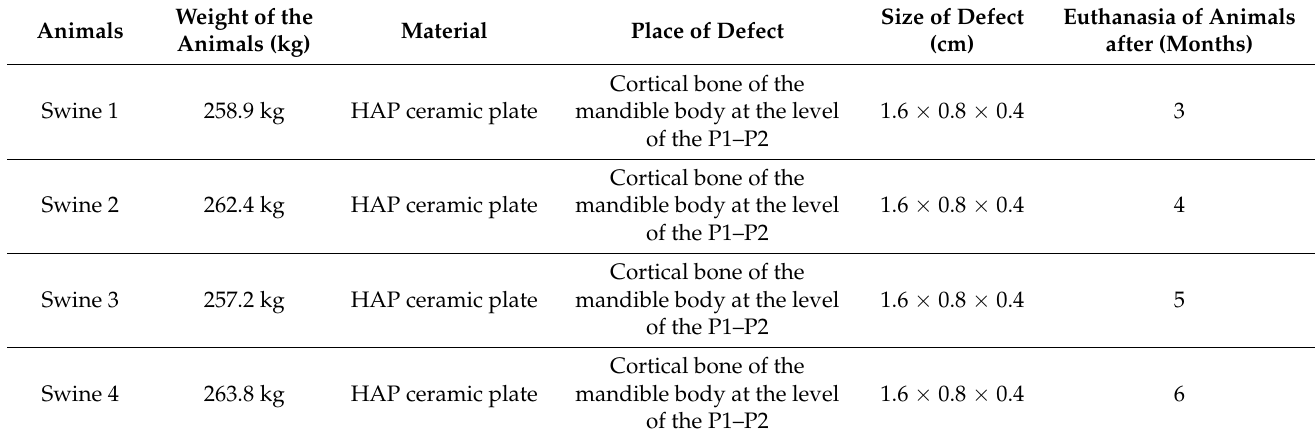
Table 2. The details of the animals used in our